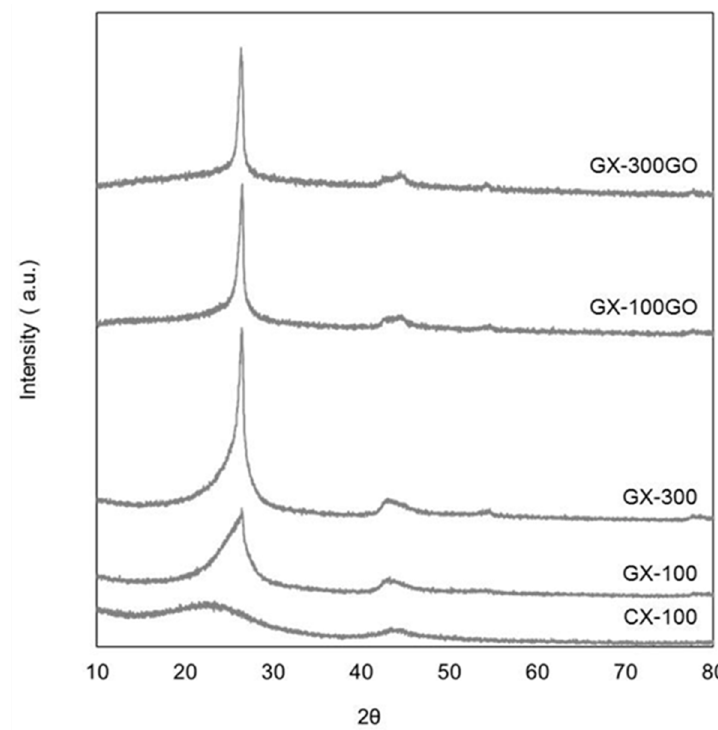
Figure 1. XRD patterns of the xerogels studied.